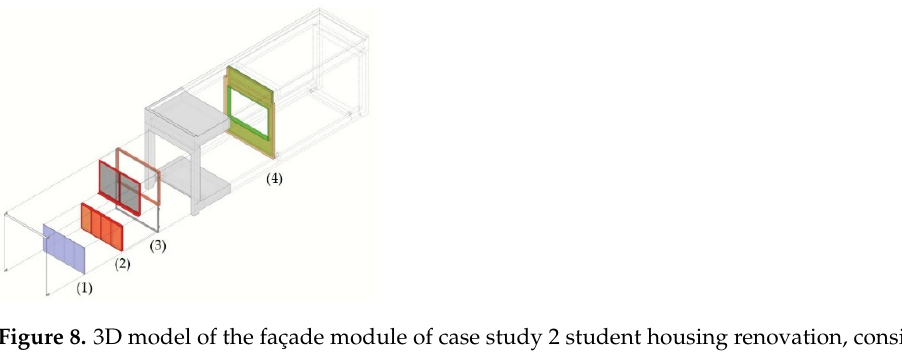
Figure 7. Case study 2: WVDM Living Lab, renovation student housing buildings Vrije Universiteit Brussel, Brussels (Belgium). Source: MAKER Architecten [57].